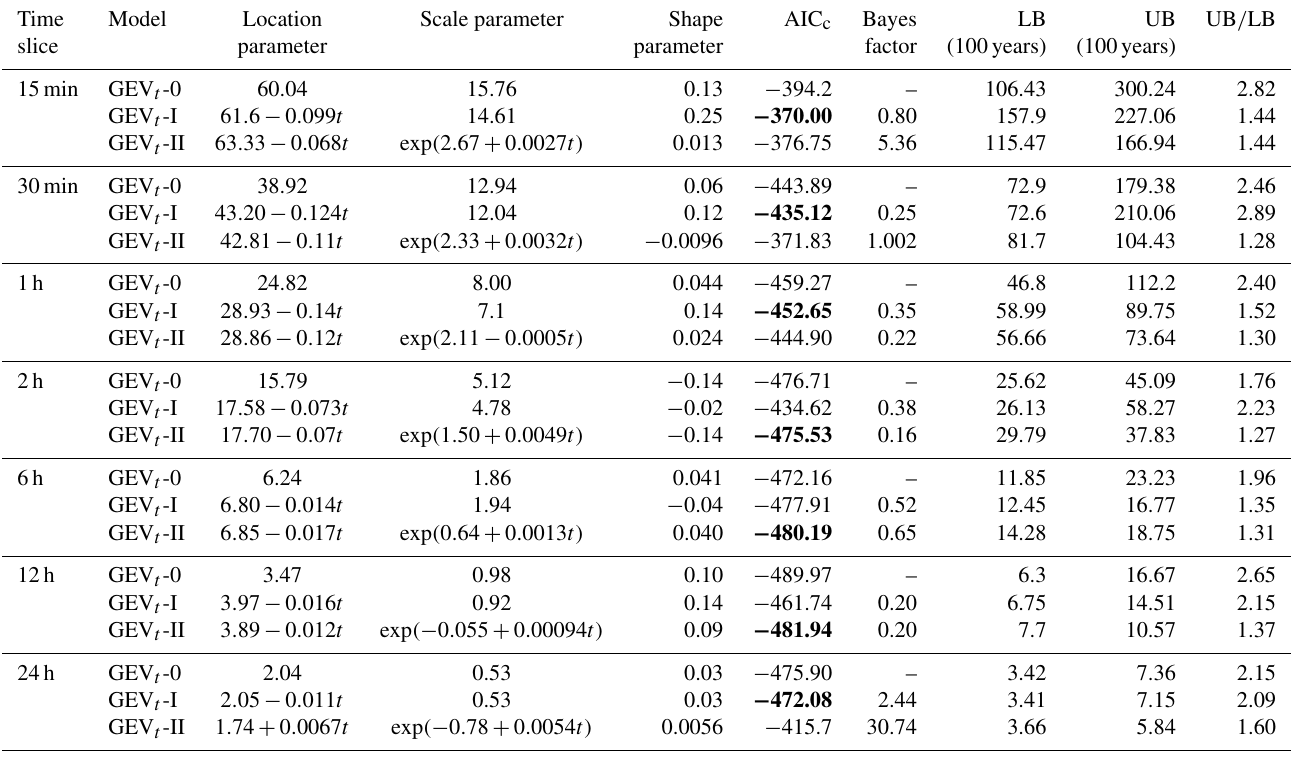
Table 4. Performance of stationary and nonstationary models for Windsor Airport.